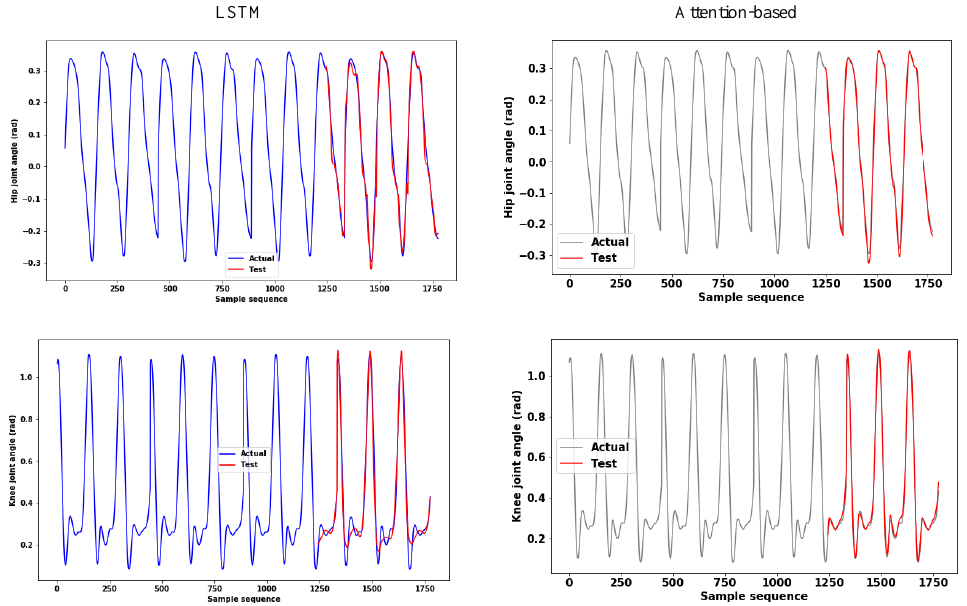
Figure 7. Gait trajectory prediction results on synthetic datasets from subject